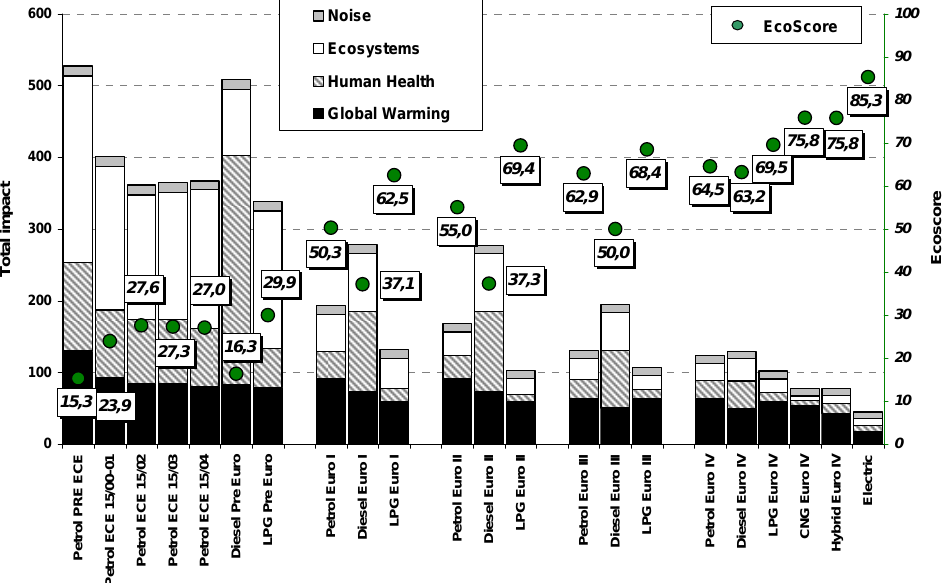
Figure 3. Total impact for the vehicle selection – category split up To analyse the potential environmental improvements of vehicles with alternative fuels or drive trains more thoroughly, the last six cars of the selection of table 5 were analysed in more detail. Direct and indirect impacts were analysed separately and are shown in figure